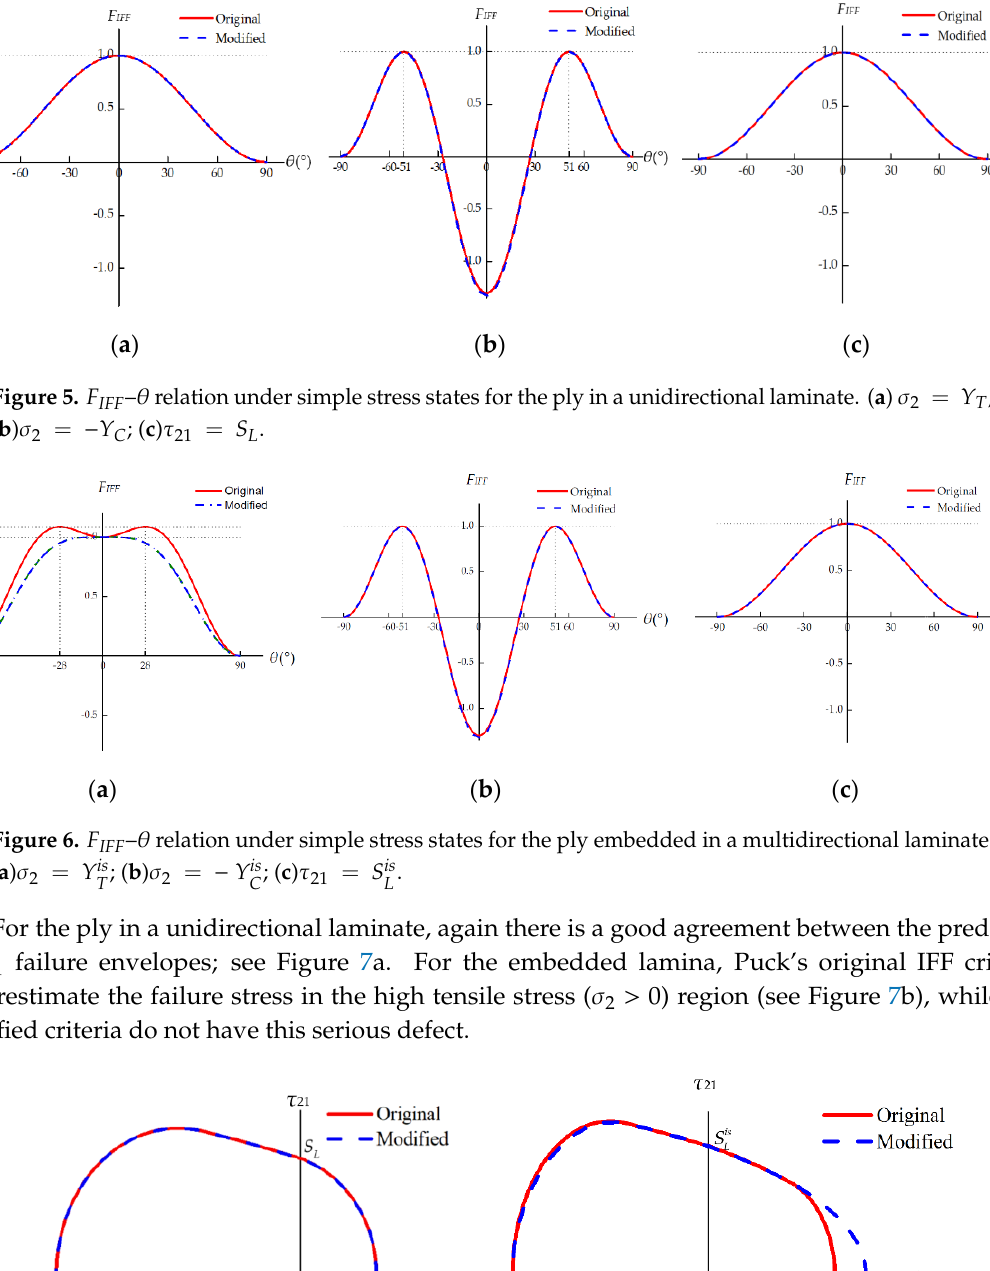
Figure 5. F IFF – θ relation under simple stress states for the ply in a unidirectional laminate. ( a )